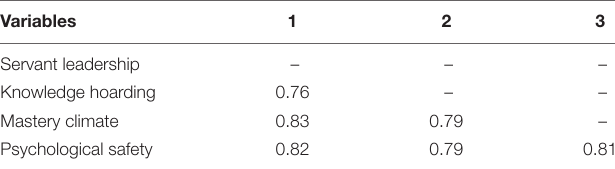
TABLE 3 | Heterotrait–monotrait ratio of correlations (HTMTs).